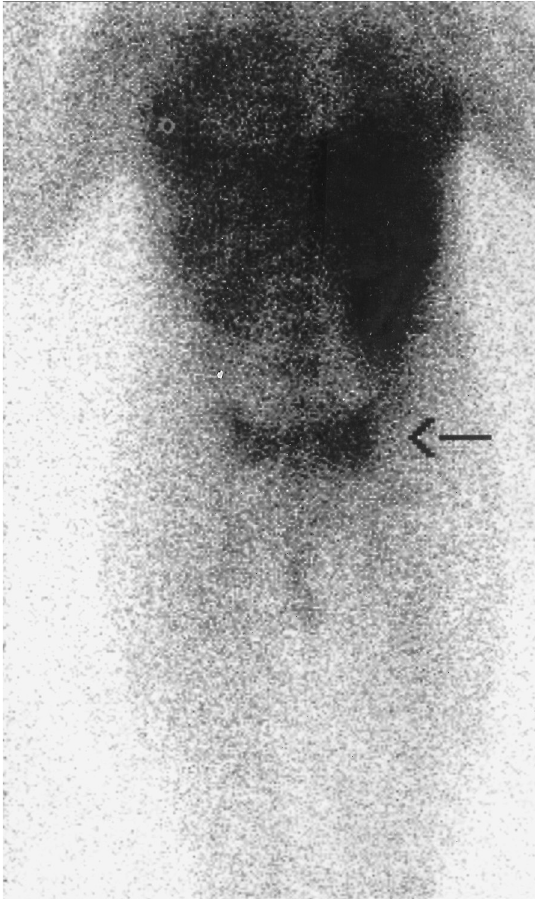
Figure 2 Gallium scintigraphy (posterior view) 24 hours after intravenous injection of Ga-67 citrate demonstrating increased uptake of the tracer in the right sacroiliac region (arrow). The uptake was greater with regard to intensity and area compared with the bone scan. The findings are consistent with right